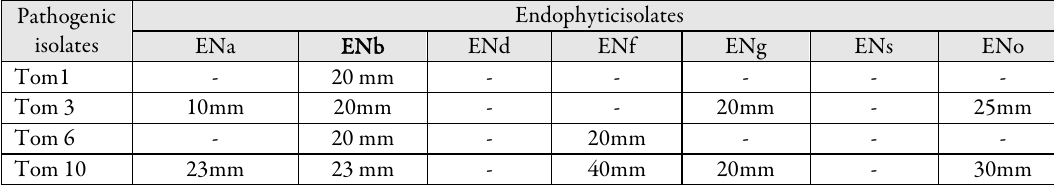
Table 1. Inhibition zone diameters (mm) of the pathogen isolates by the endophytic strains